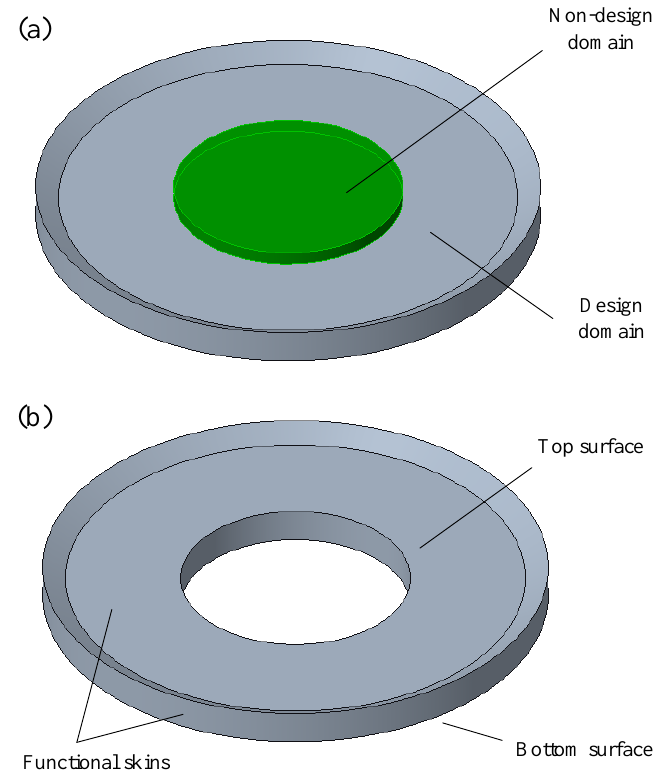
Figure 12. The 3D model of the footpad. ( a ) Footpad; ( b ) lattice structure design domain.